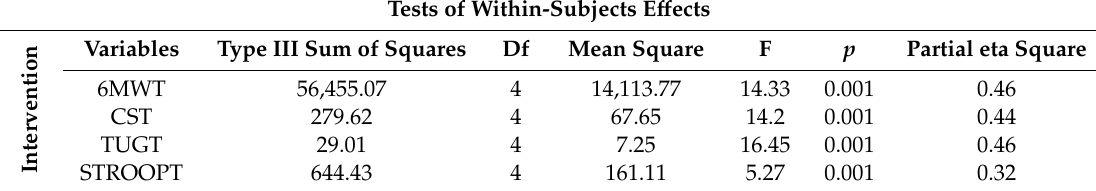
Table 2. Training and detraining changes in physical and cognitive function along two years of EFAM-UV © .